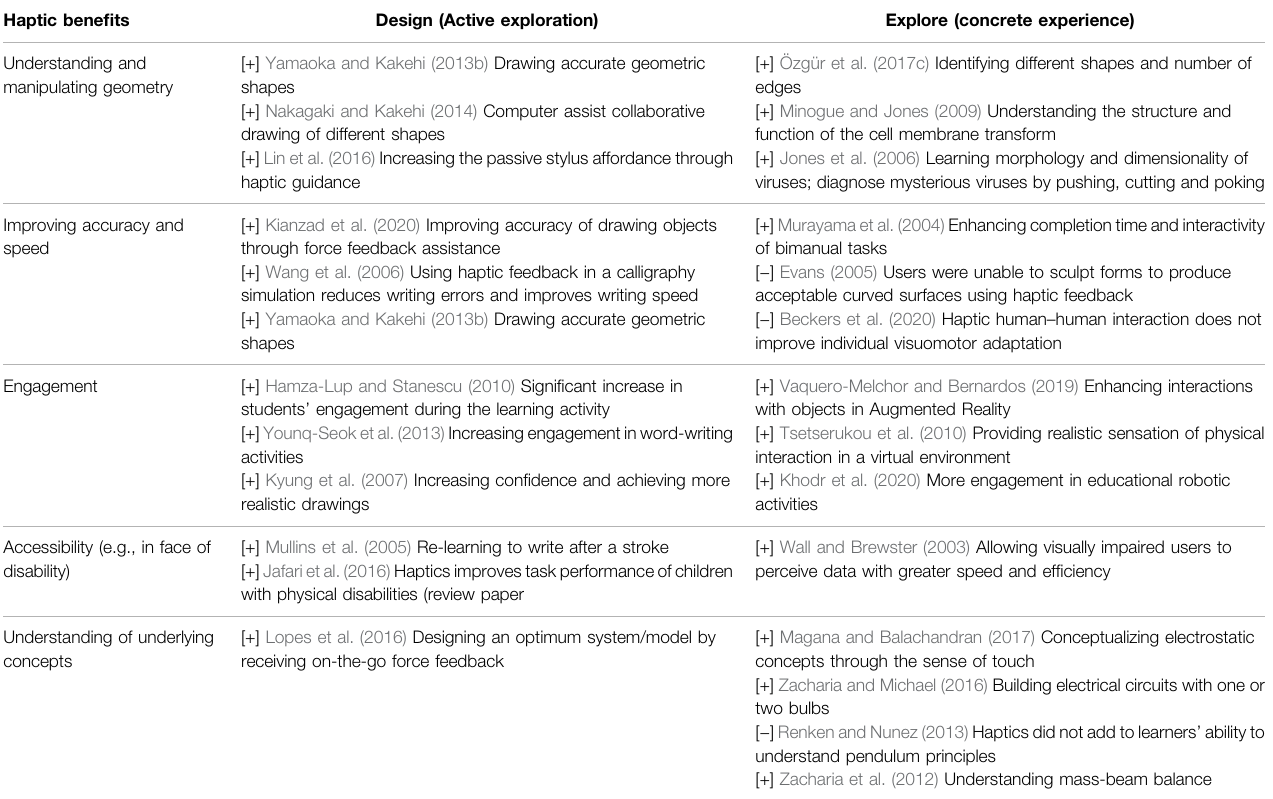
TABLE 1 | Summary of research informing the use and bene fi ts of haptics in learning, organized by the PAL framework ’ s two activity components. [+] indicates a positive bene fi t, or [ − ] no added value was found. Haptic bene fi ts Design (Active